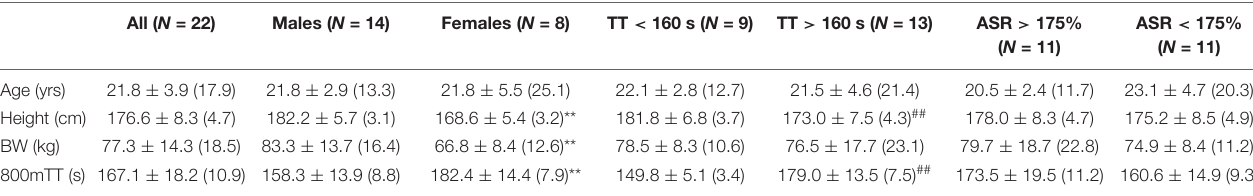
Values are mean ± standard deviation, with coefficient of variance in percent in parenthesis. yrs, years. cm, centimeters. kg, kilograms. s, seconds. m, meters. TT, 800-m time trial. **p < 0.01 significantly different from males. ## p < 0.01 significantly different from 800 TT < 160 s.